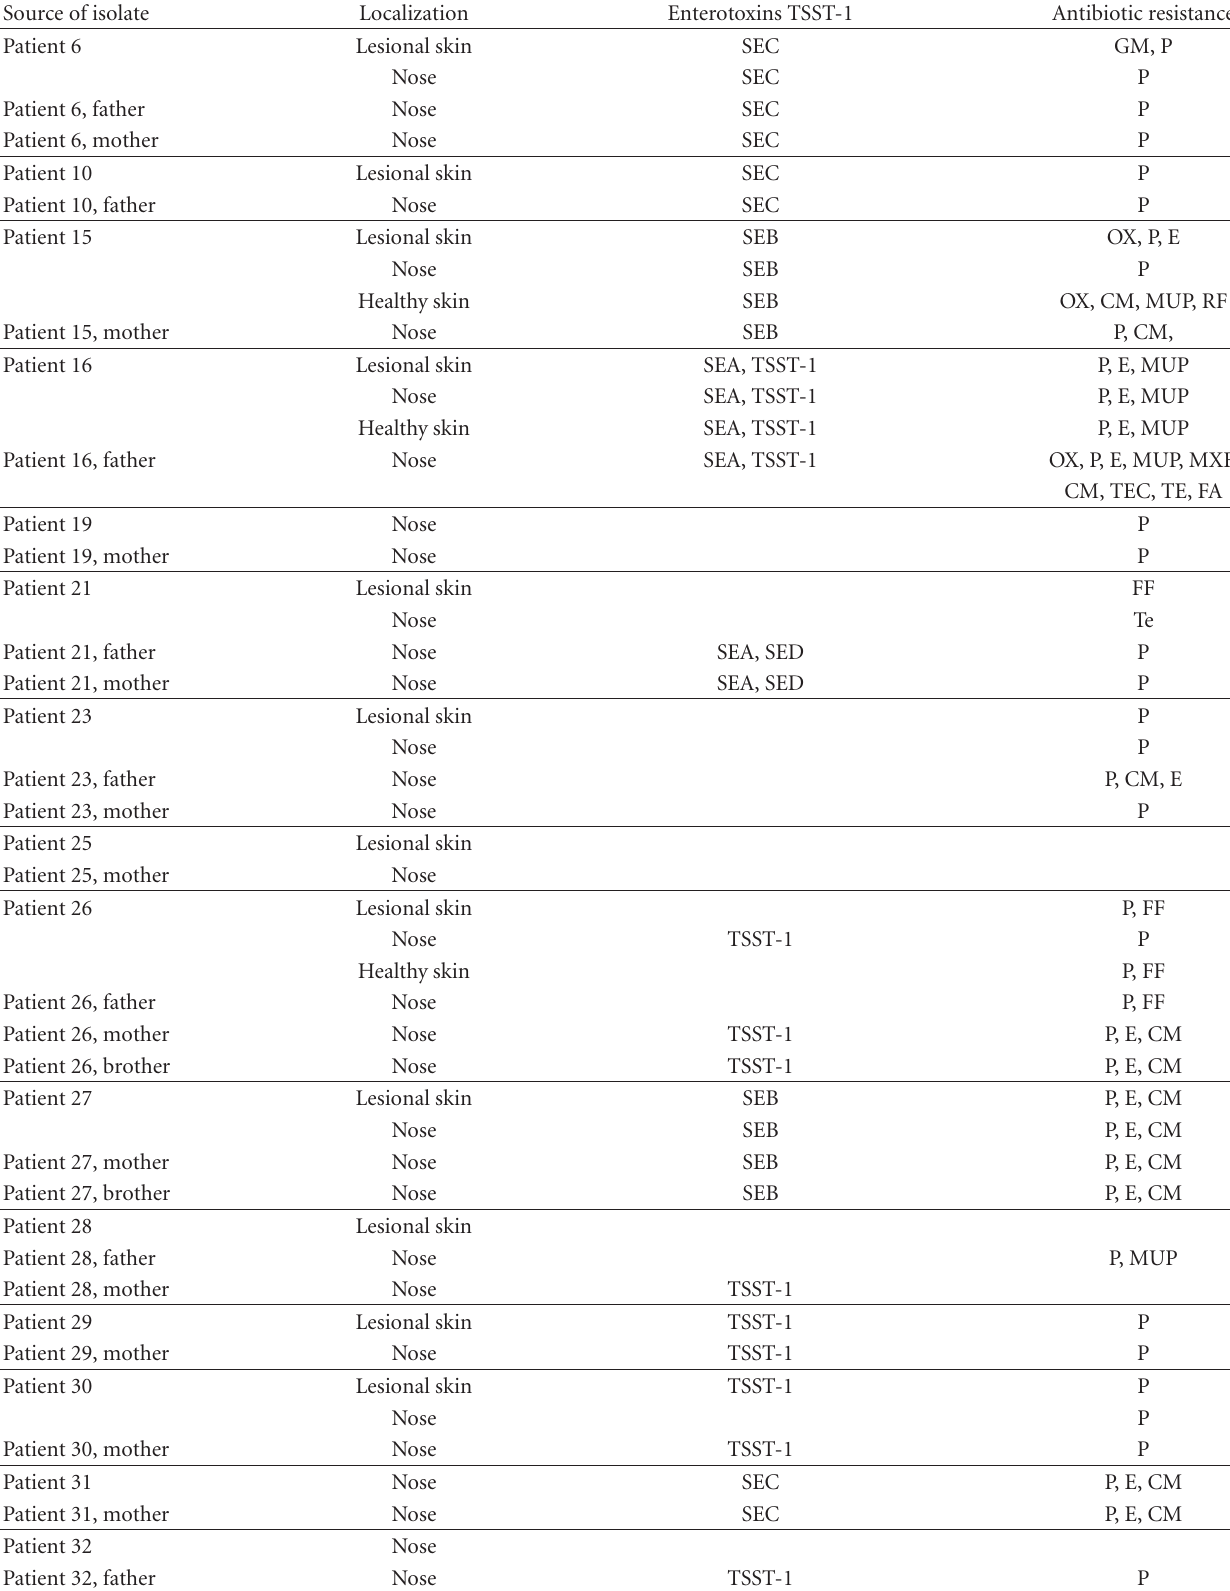
Table 6: Immunological detection of toxin array and drug resistance of S. aureus isolates from patients and their family members. Source of